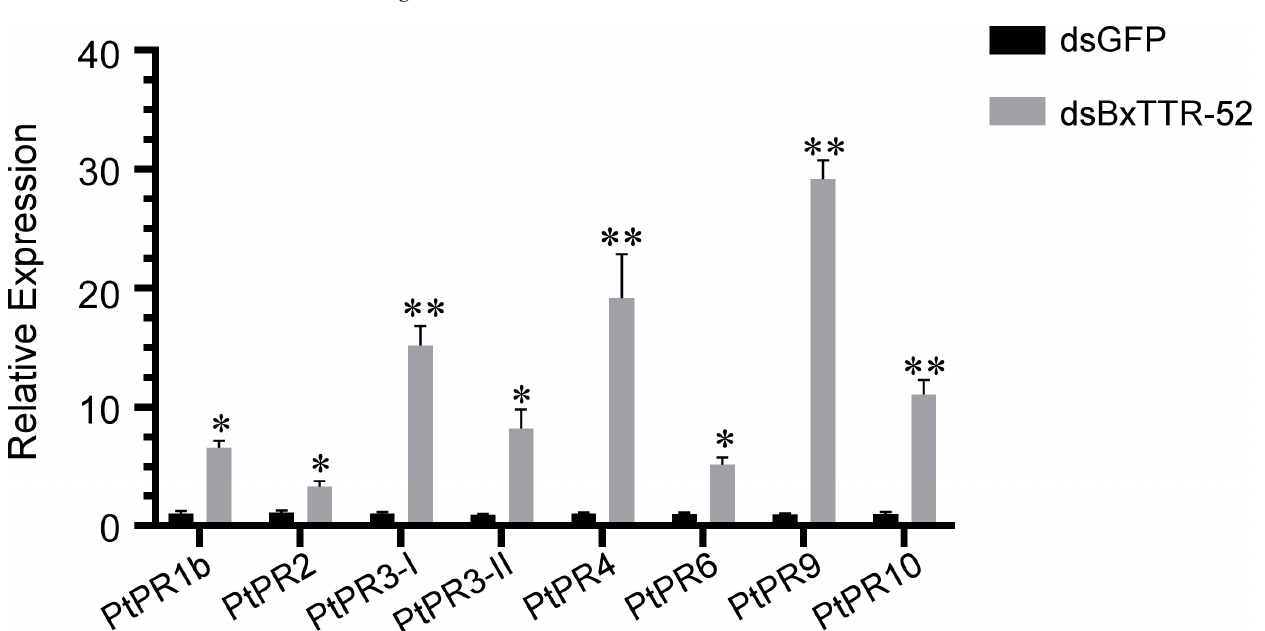
Figure 6. The relative expression of pathogenesis-related genes in Pinus thunbergii infected with BxTTR-52 siRNA-treated nematodes. We selected stems ~2 cm in length to extract RNA at 12 h postinoculation. Values represent the means ± SD of three independent biological samples. * indicated statistically significant differences ( p < 0.05, t -test) as measured by Duncan’s multiple range test. ** indicated statistically significant differences ( p < 0.01, t -test) as measured by Duncan’s multiple range test.